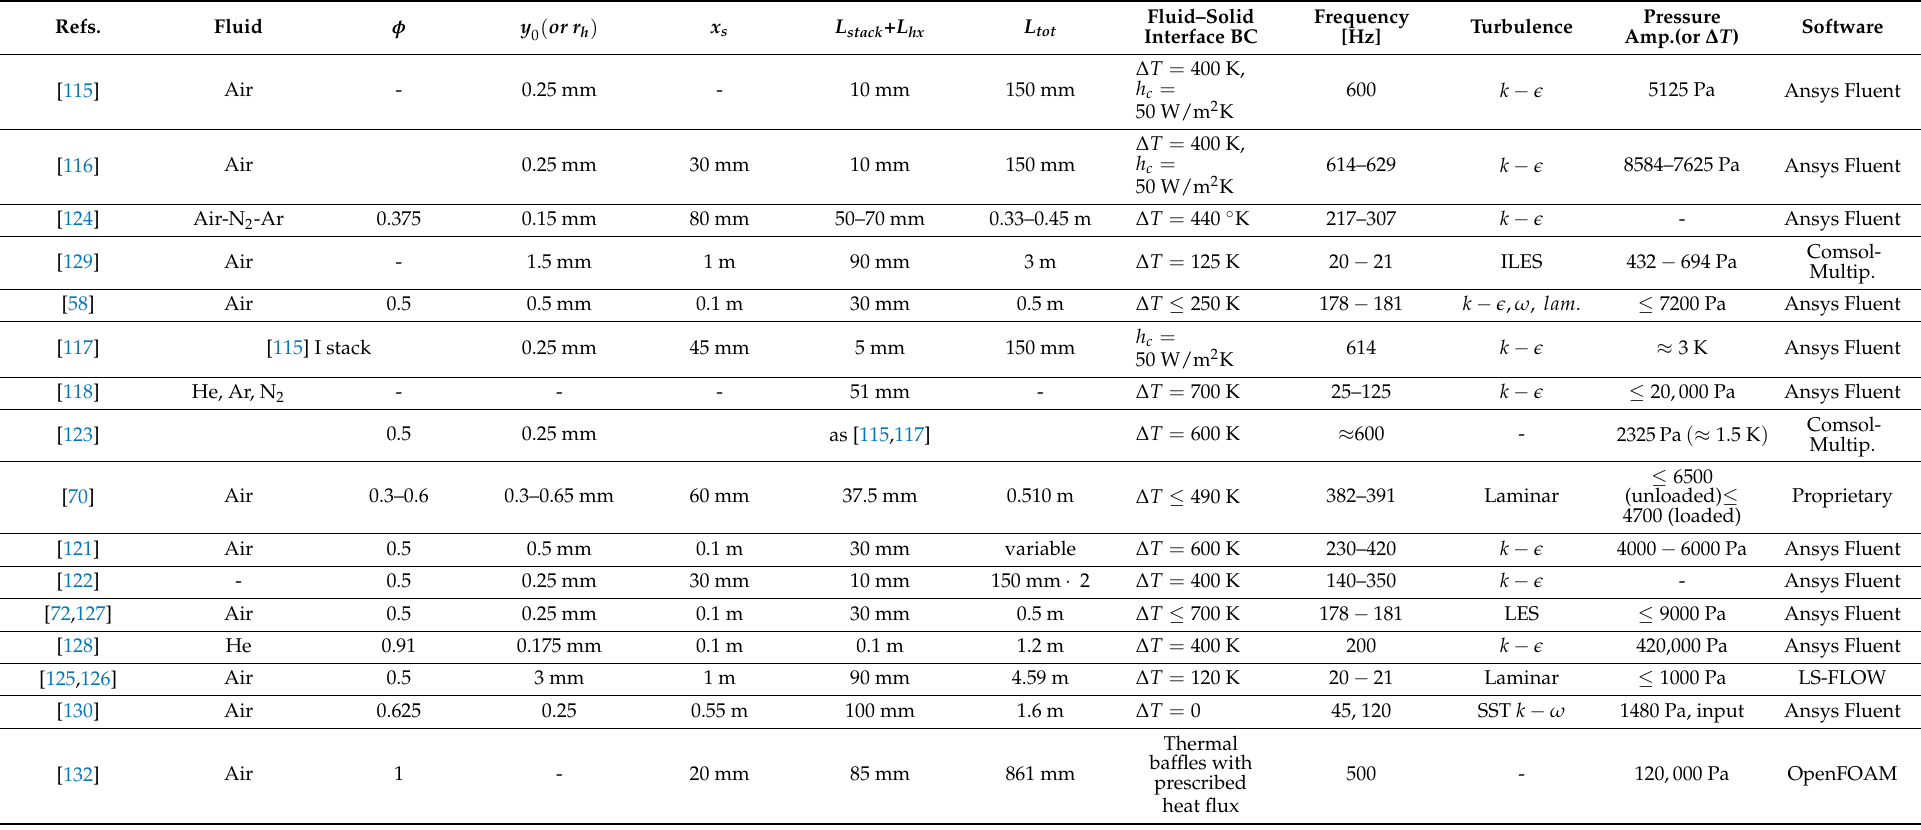
Table 4. Detailed characteristics of full device simulations at the microscopic